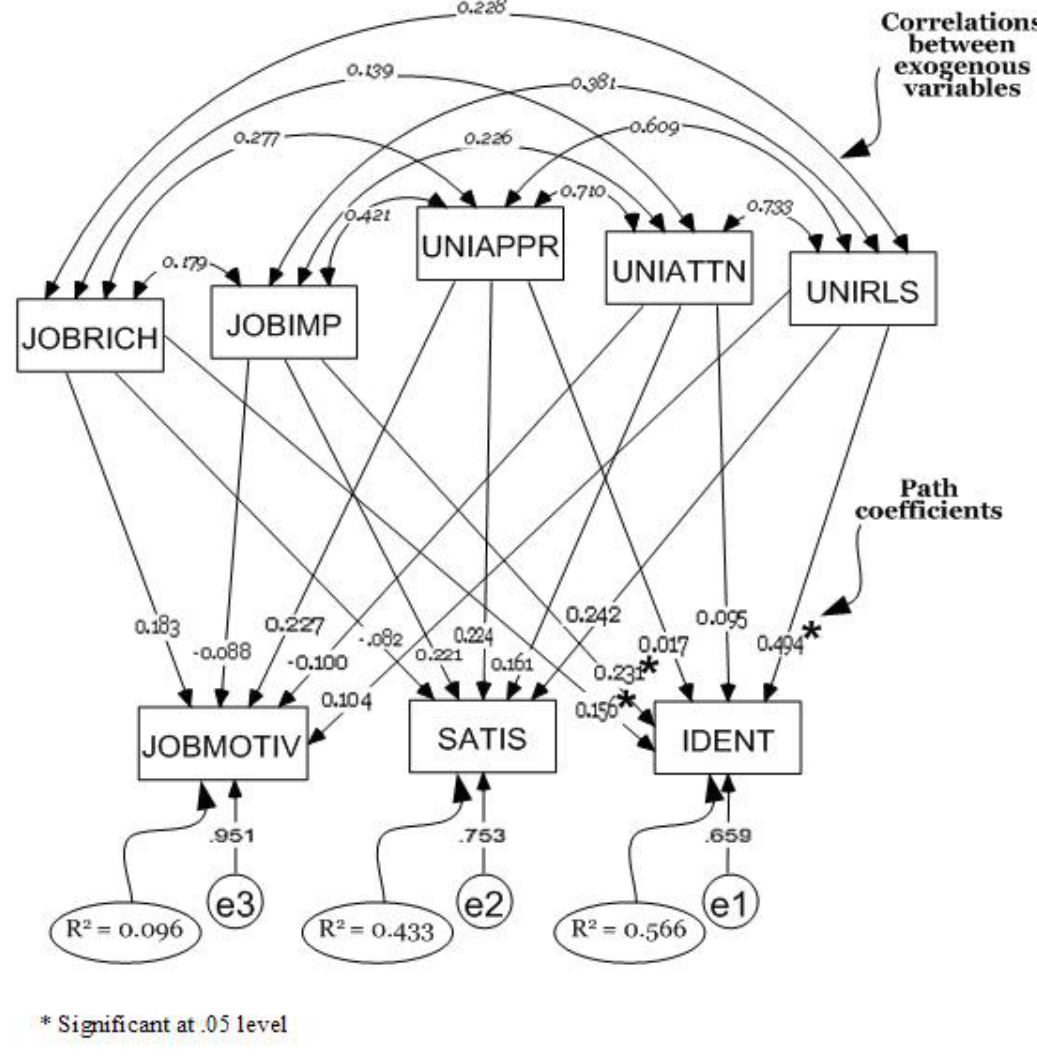
Figure 1. A path model of the effect of perceived organizational attachment and perceived job characteristics on organizational identification, job satisfaction, and